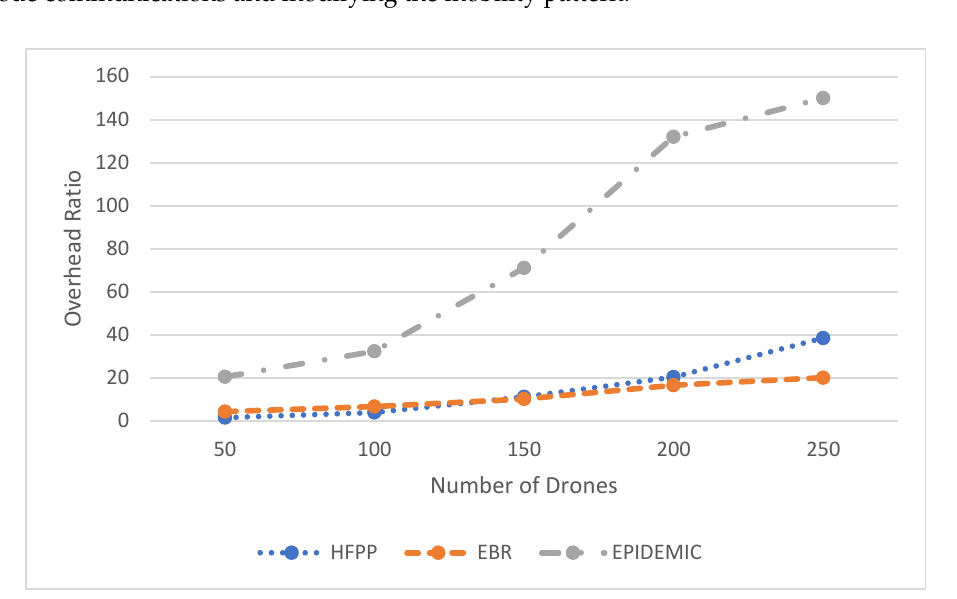
Figure 4. Overhead ratio of comparable schemes when number of drones varies.